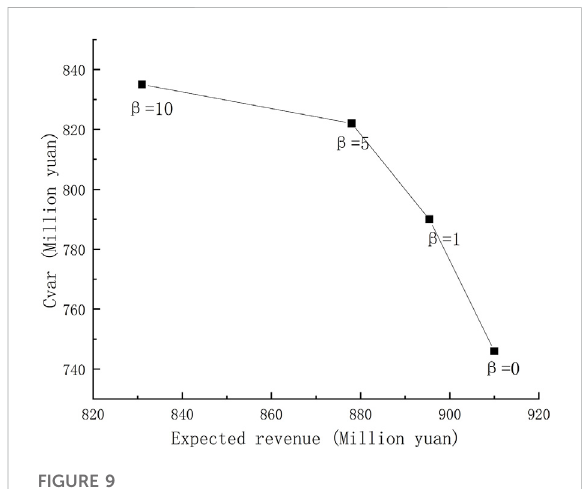
FIGURE 9 Expected pro fi ts of PSPP under different risk